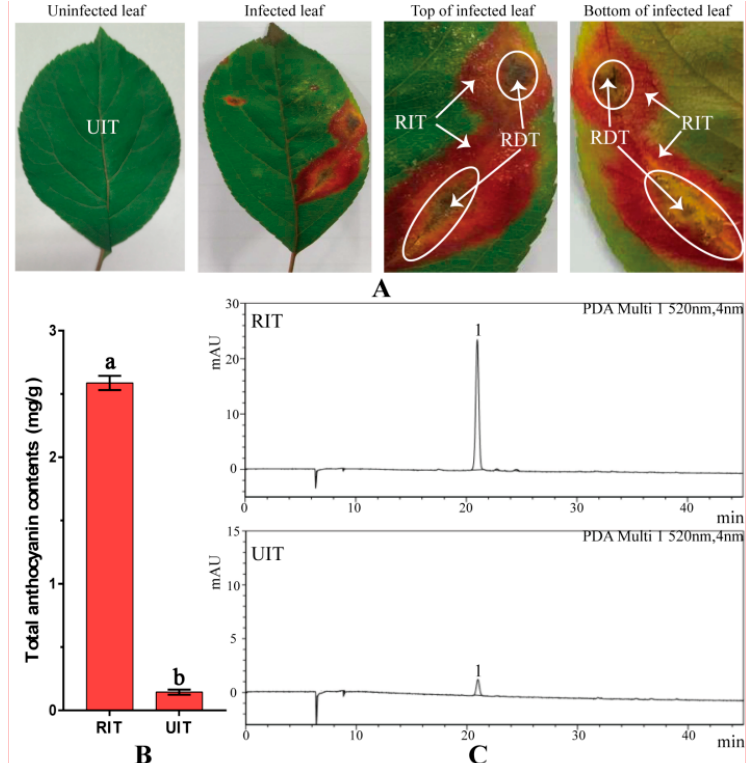
Figure 1. Images of Malus ‘Profusion’ leaf and anthocyanin contents in rust-infected red leaf tissue (RIT) and uninfected tissue (UIT). Shown are ( A ) Images of M . ‘Profusion’ leaves. Ellipses indicate rust-infected diseased leaf tissue (RDT); ( B ) Total anthocyanin content in RIT and UIT. (Data shown are the means ± SD of three biological replicates. The different letters represent significant differences between UIT and RIT, as judged by the paired t -test, p < 0.05); ( C ) HPLC and photo-diode array (PDA) trace images for anthocyanin in RIT and UIT (detected at 520 nm; peak 1 indicates cyanidin-3-galactoside chloride).